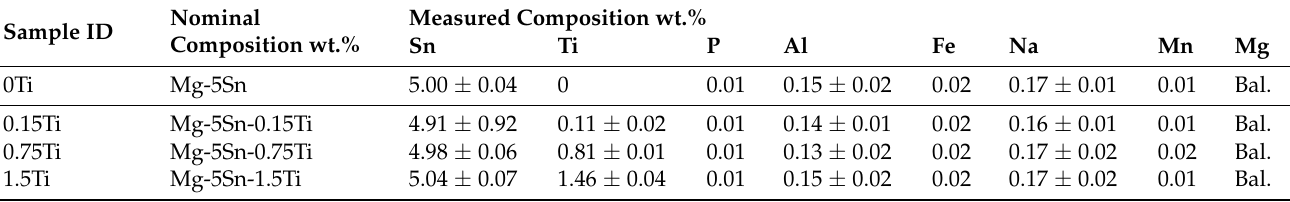
Table 1. Chemical composition (wt.%) of the alloys.